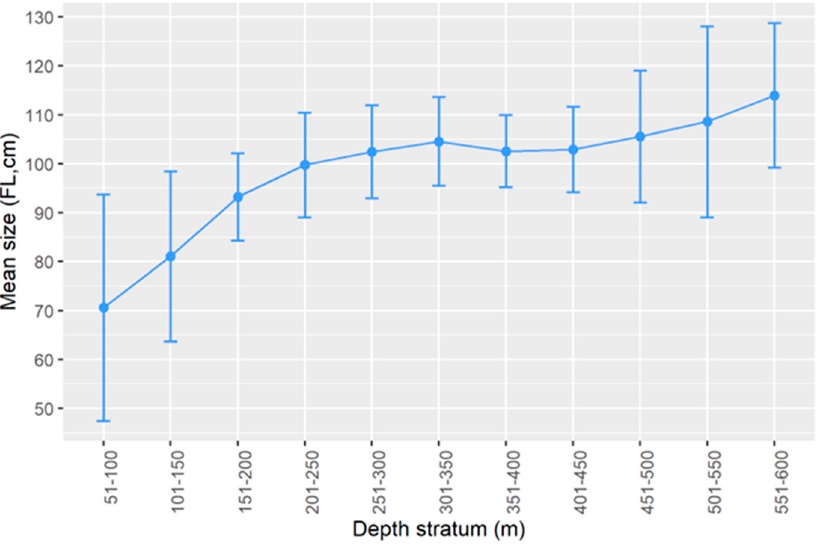
Figure 4. Mean fork length (FL) by depth stratum of Lepidopus caudatus in the Azorean waters from scientific surveys (1996–2019). The bars represent the 95% confidence intervals.